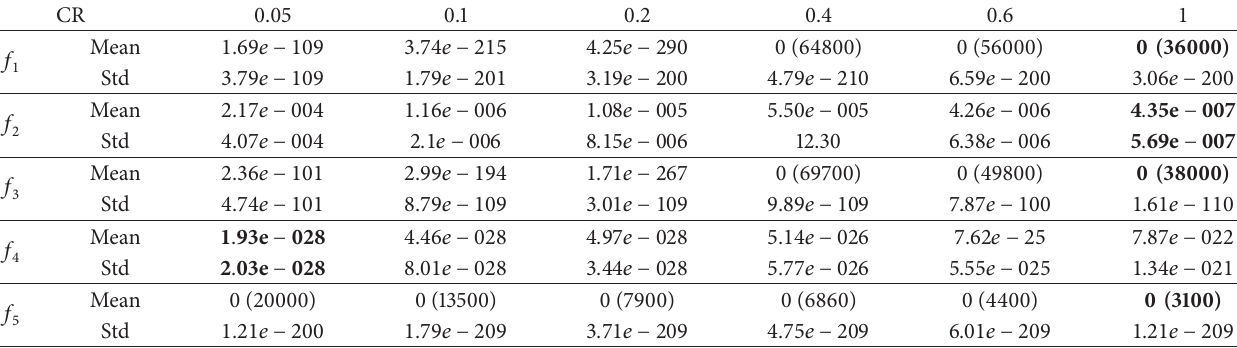
Table2:PerformanceofHABCon100 𝐷 benchmarkfunctions 𝑓 1 – 𝑓 5 withdifferentCRs.Inboldarethebestresults.Notethatvaluesindicated in brackets denoted to function evaluations (FEs) are used to obtain the optimal value.